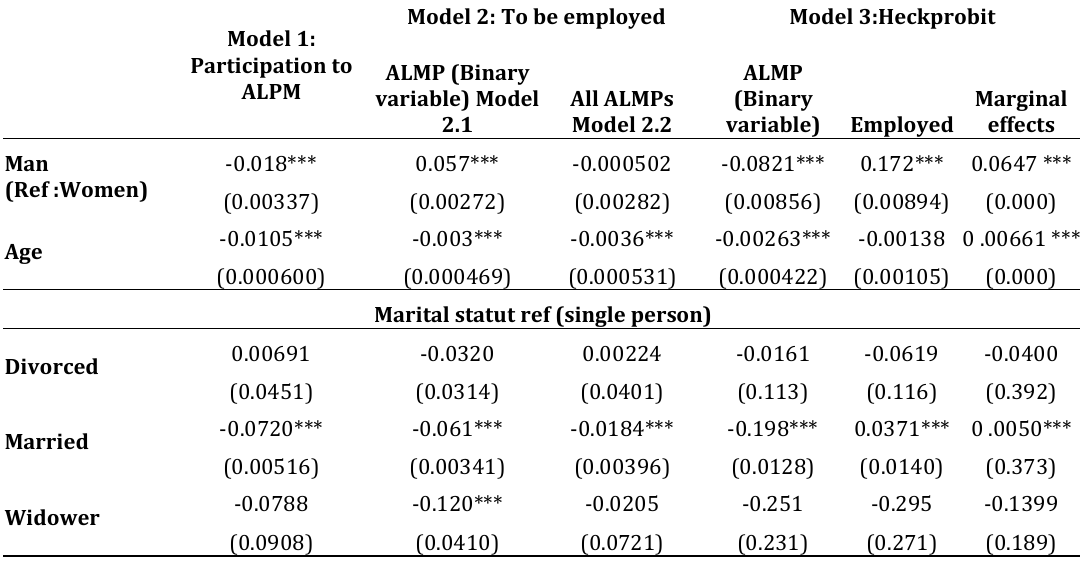
Table 3: Impact of biographical characteristics on ALMPs participation and professional